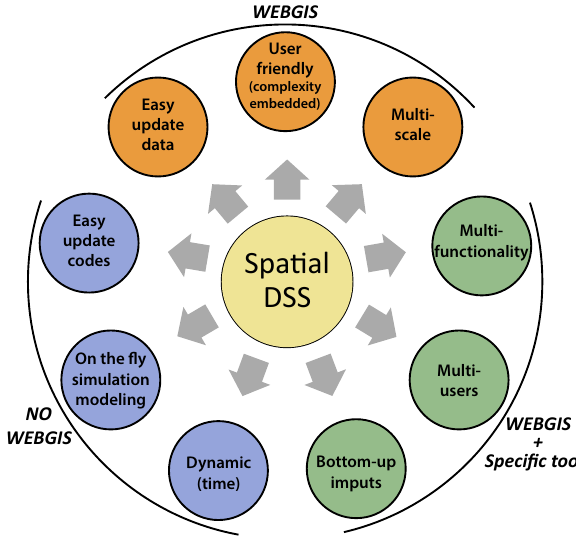
Figure 1. Features to be expected of a spatial DSS system in or- der to address current complexity of agriculture and environmental